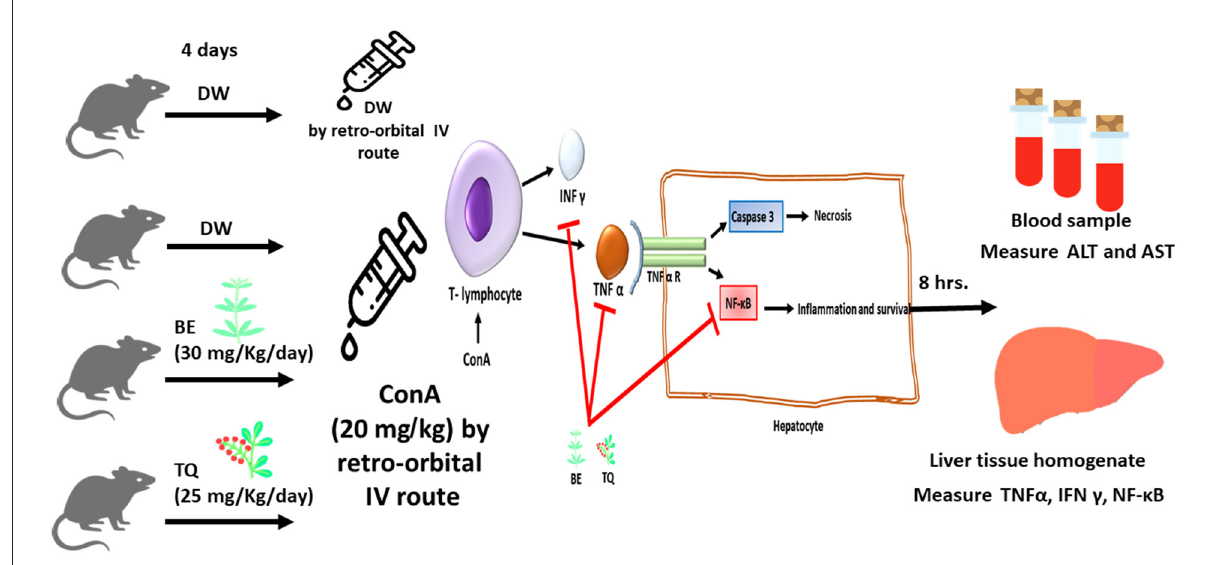
FIGURE1 The schematic diagram of the study design with the suggested mechanism of action of Berbamine and Thymoquinone.